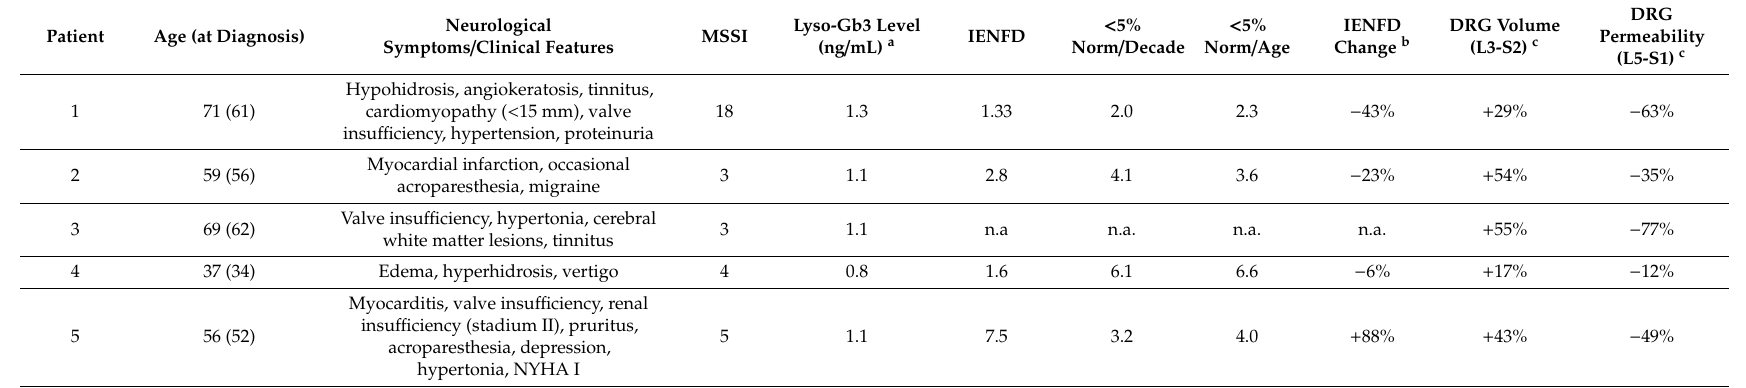
Table 1. Patient demographics and clinical data Mainz Severity Score Index (MSSI). a Reference values: Lyso-Gb3 (plasma) < 2.2 ng / mL. b compared to < 5% norm / age, c compared to sex-matched